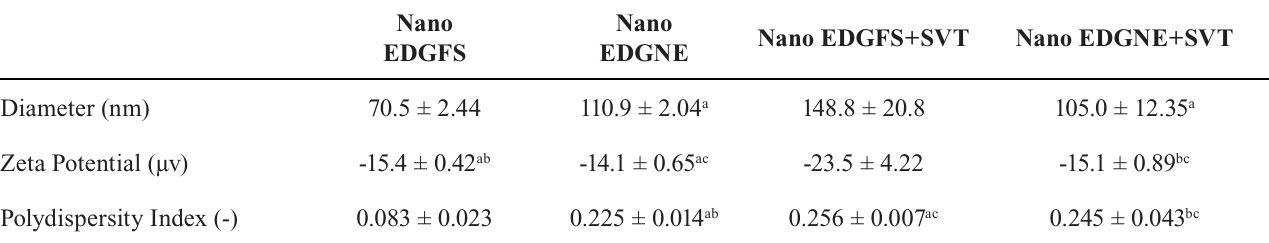
TABLE I - Mean diameter and Zeta potential of the Eudragit ® nanoparticles unloaded and loaded with